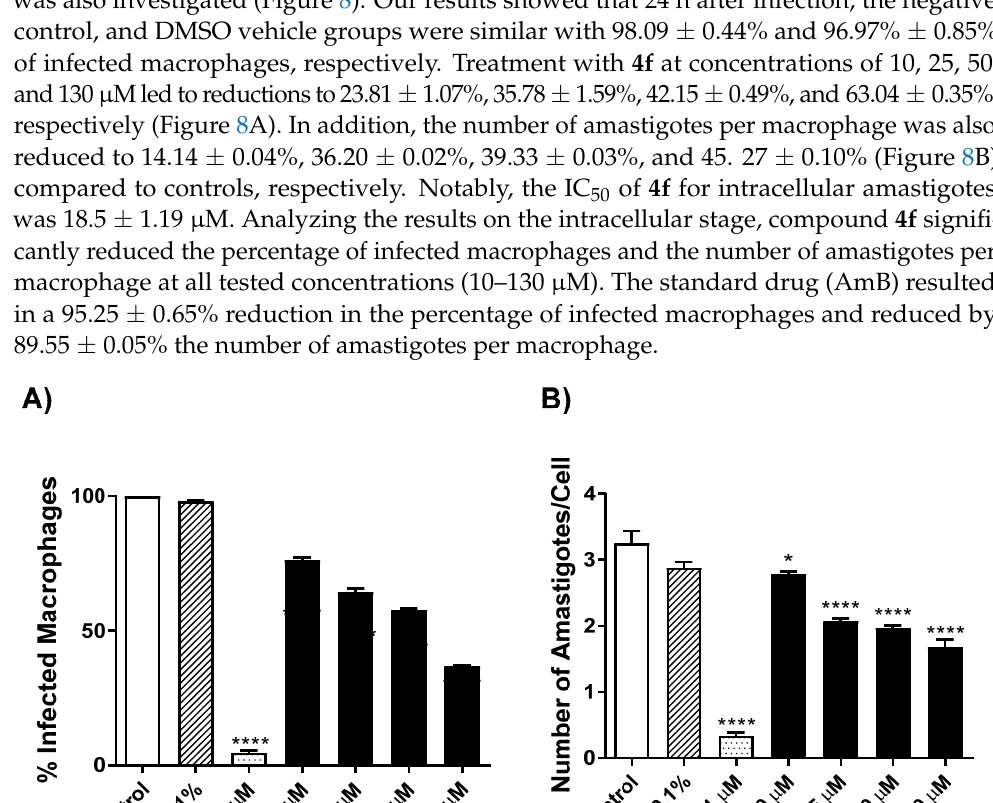
Table 2. In silico prediction of physicochemical (Lipinski’s 5 Rule and Veber's extension), pharmacokinetics, and toxicity properties of 4f .